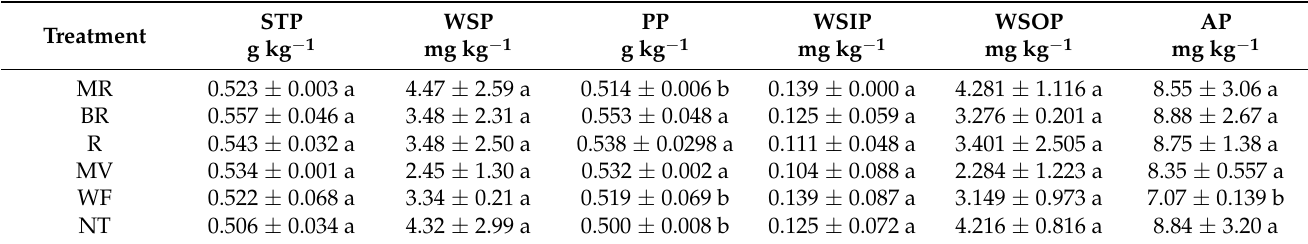
Table 3. Effects of different treatments on components of soil